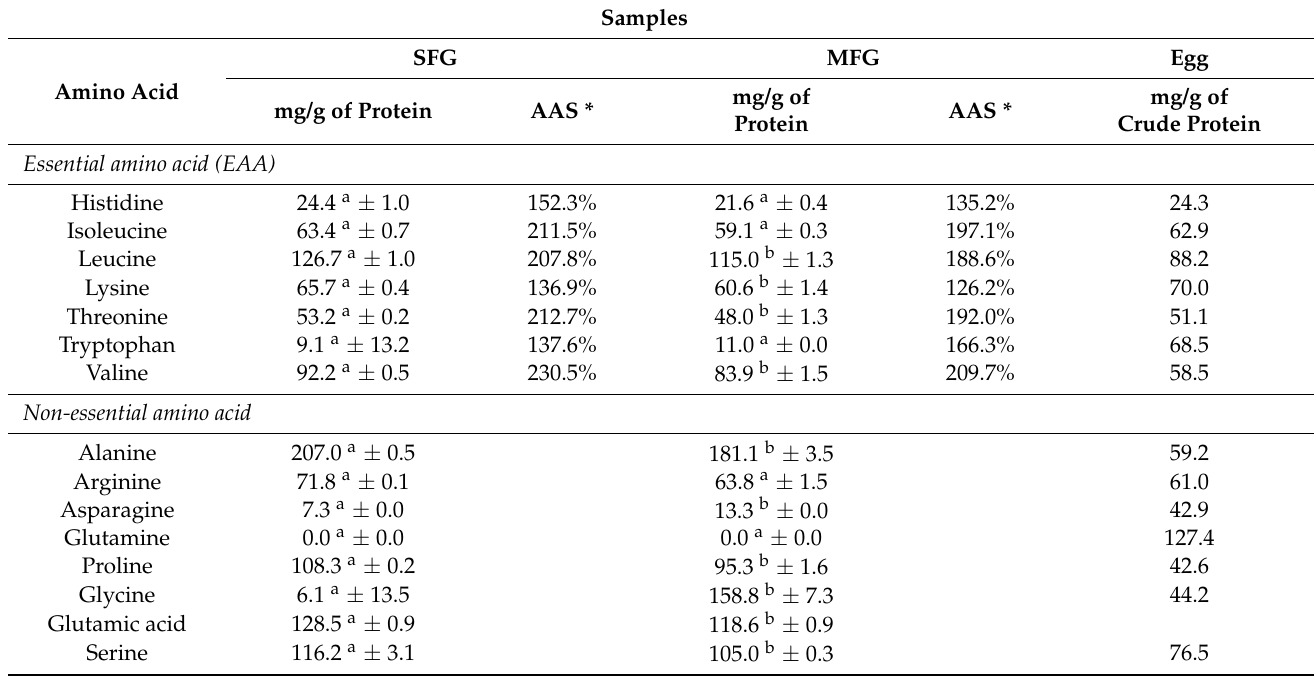
Table 3. Amino acid profile of soy sprout-fed grasshoppers (SFG) and maize leaf-fed grasshoppers (MFG).